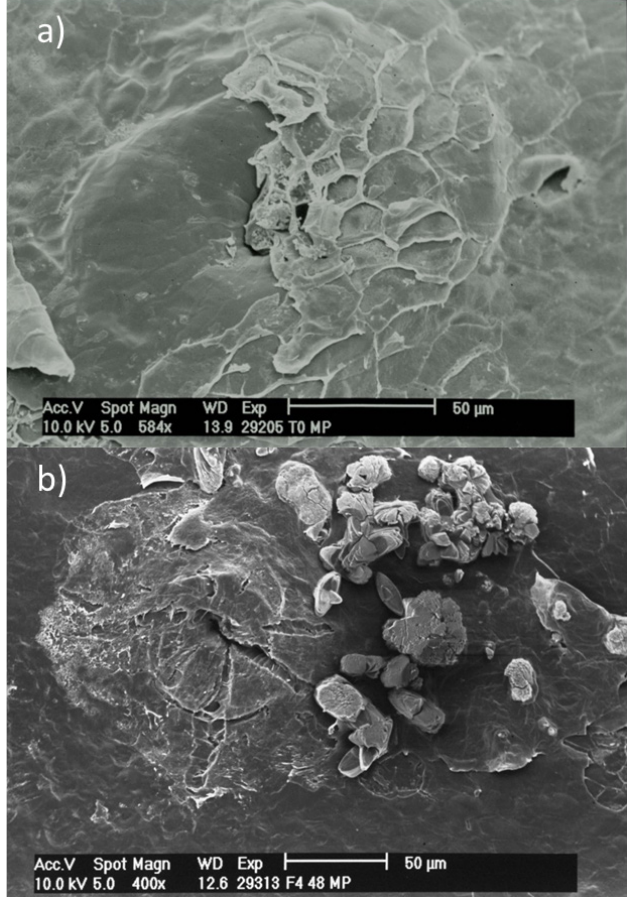
Fig. 11: a) SEM image of cacao micropyle from the inside of the testa of the seed before incubation. b) SEM image of cacao micropyle